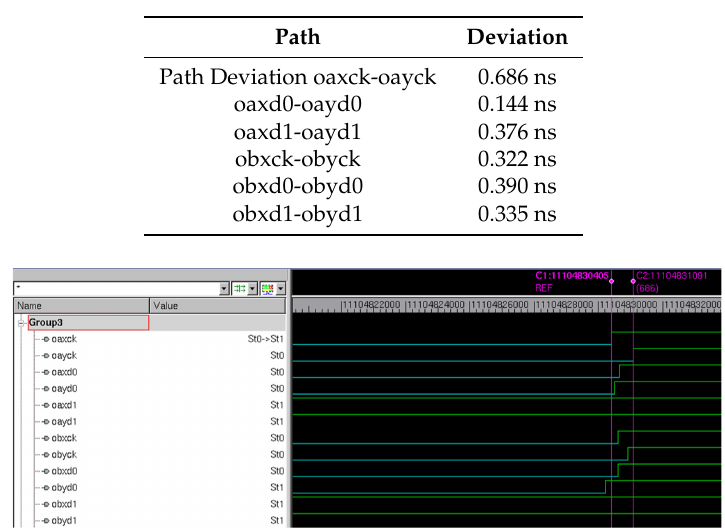
Table 2. Simulation results of the output bus signals.